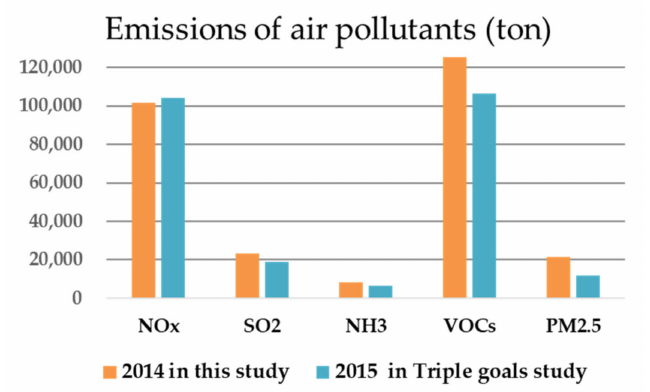
Figure 11. Comparison of levels of emissions between the findings of this study and those of the Triple Goals Study